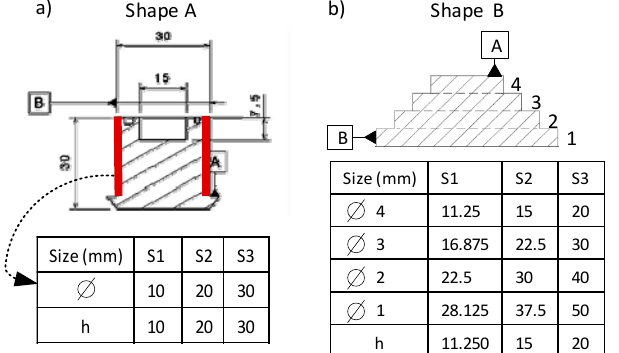
Figure 3. Features inspected with nominal dimensions indicated in tables . ( a ) Shape A ( b ) Shape B.